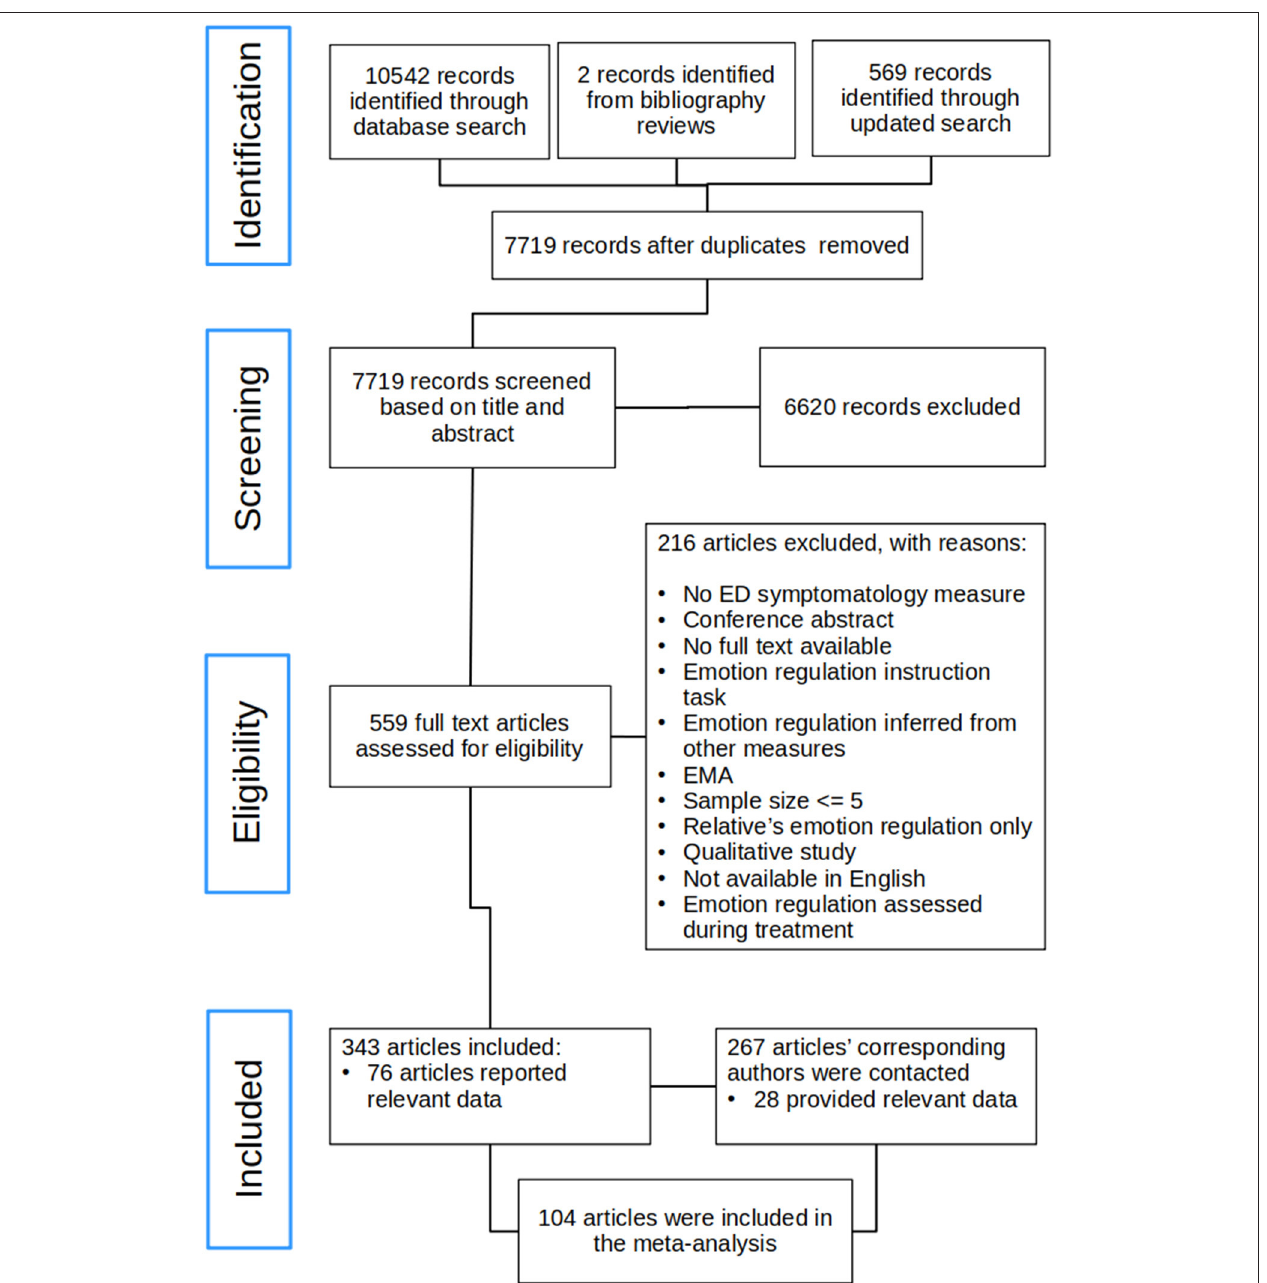
FIGURE 1 | Flow diagram. ED, Eating disorder; EMA, ecological momentary